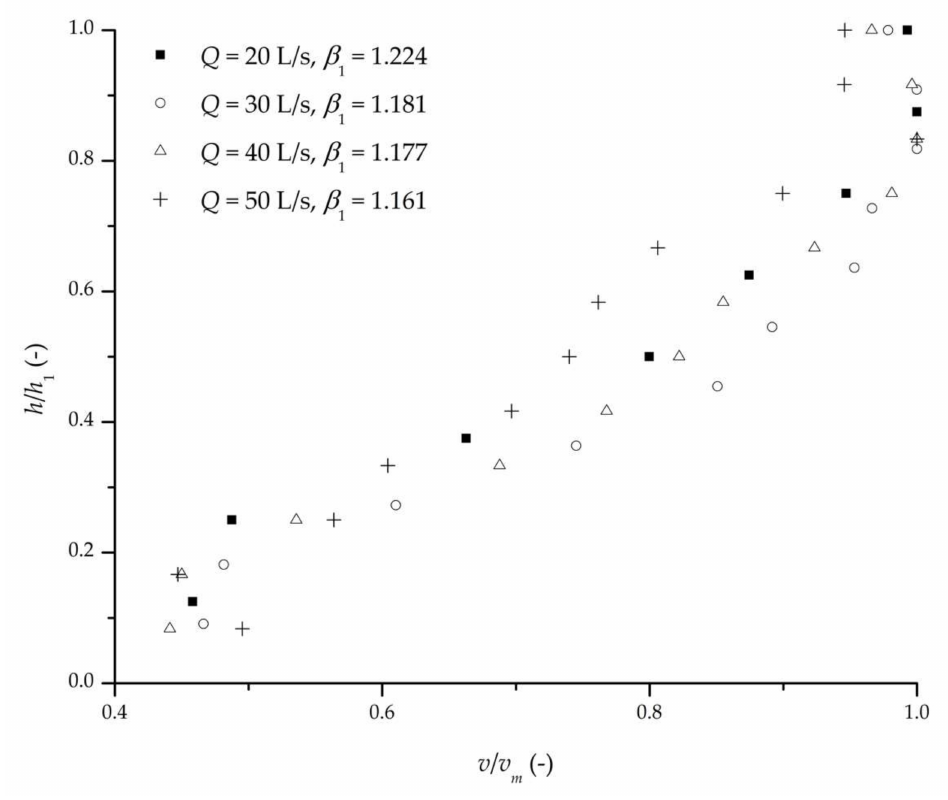
Figure 7. Relative velocity profiles at Section 1 for L 1 = 13.5 cm, where v m is the maximum profile